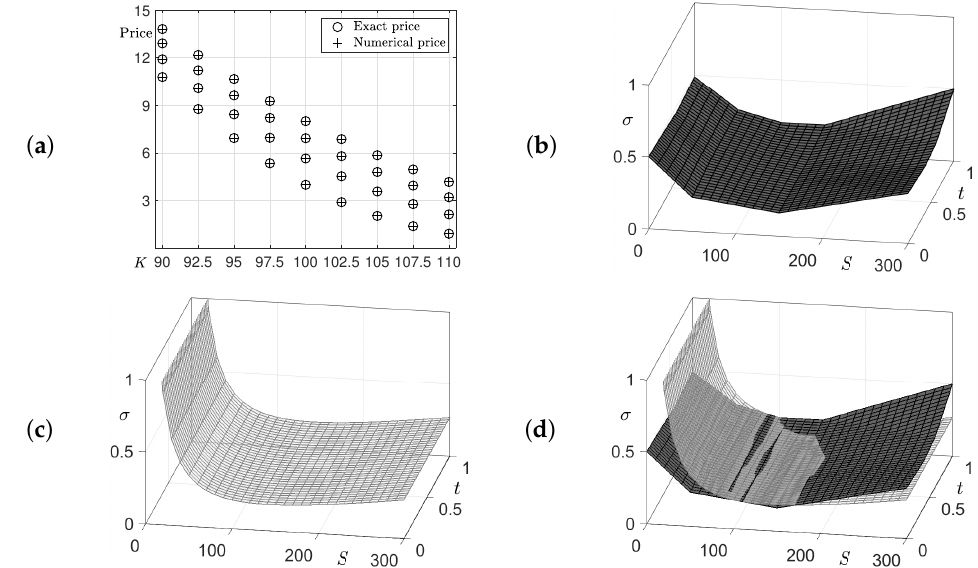
Figure 6. ( a ) Option prices computed using the given and reconstructed local volatility func- tions. ( b ) Reconstructed local volatility function. ( c ) Given local volatility function σ ( S , t ) = (cid:16) (cid:17) + ( S − S 0 ) 2 0.1 1 + S 0 . ( d ) Overlapped surfaces of ( b , c S 100 S